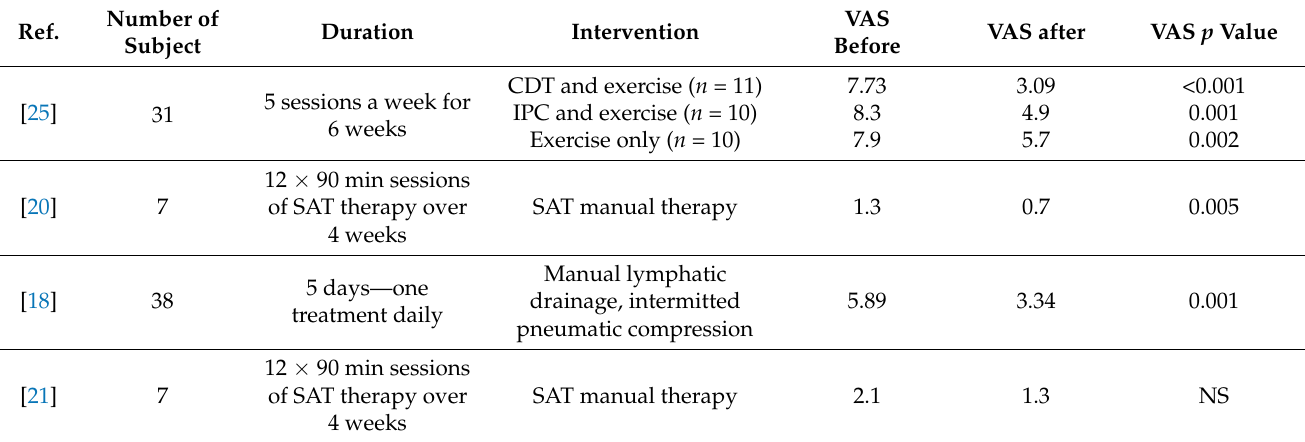
Table 4. The effects of therapeutic outcome in lipoedema treatment measured with VAS.